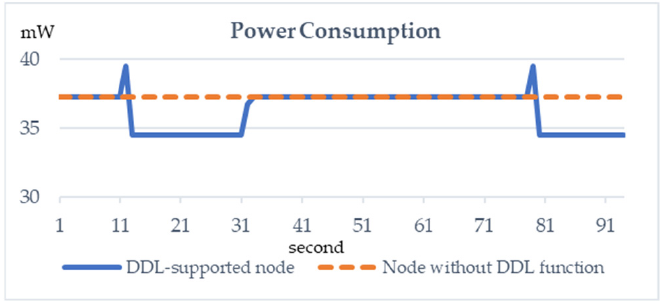
Figure 10. The change in standby power consumption of two nodes.